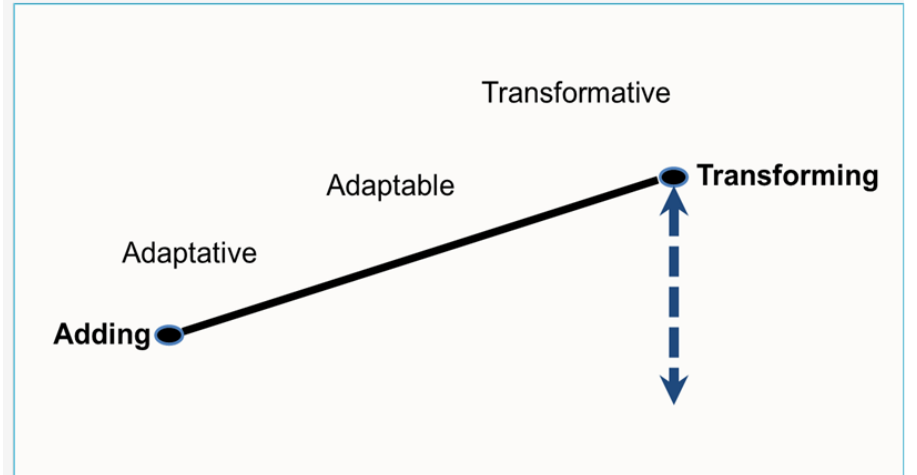
Figure 2. Enhancement continuum (Harvey, 1999, p.